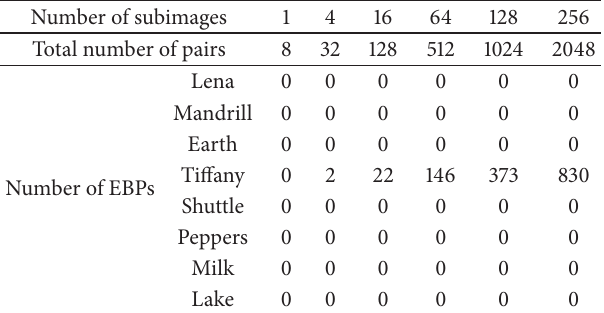
Table 8: Numbers of equivalent black pixel pairs in eight test images using the proposed